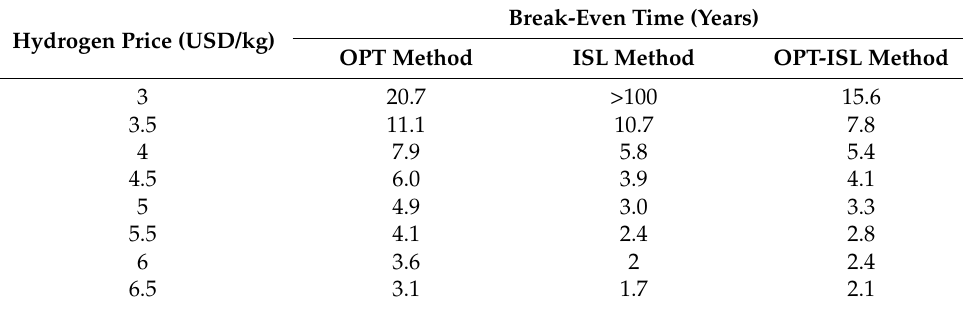
Figure 11. Total gross income for HRS during operating life with USD 3.5/kg price of hydrogen. Table 5. Break-even Years with Different Hydrogen